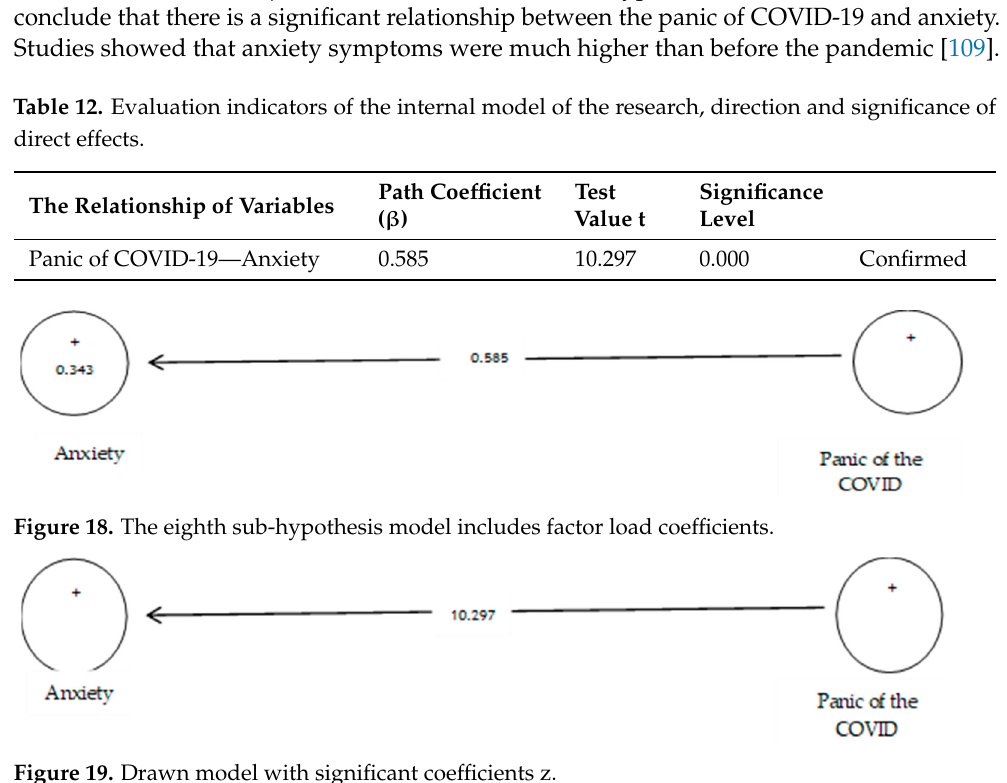
Figure 17. Drawn model with significant coefficients z. Table 11. Evaluation indicators of the internal model of the research, direction and significance of direct effects.